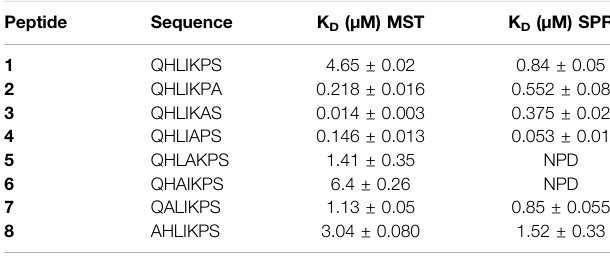
TABLE 1 | The binding af fi nities between ANXA4 and peptide 1 − 8 determined using MST and SPR. Peptide